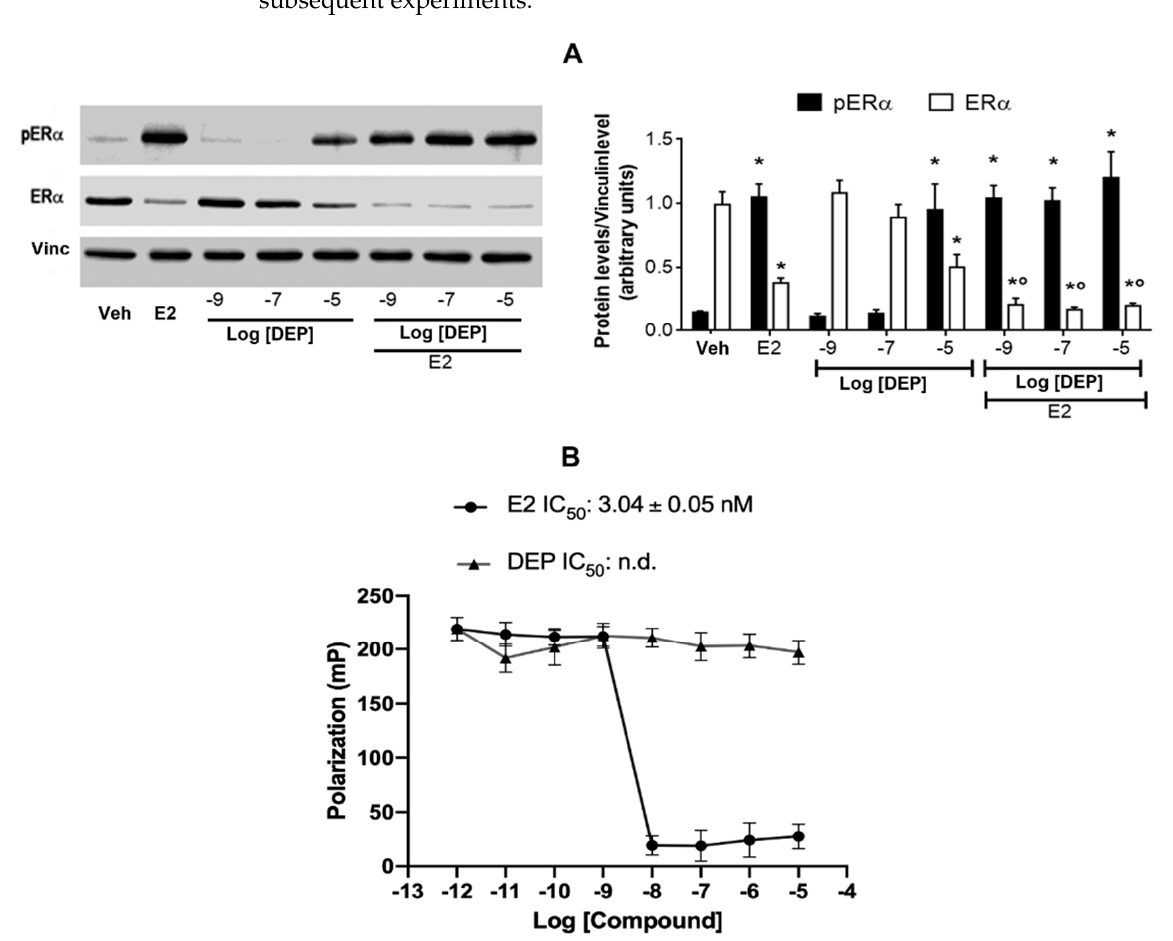
Figure 1. ER α activation and in vitro binding assays. Western blot ( left panel ) and corresponding densitometric analysis ( right panel ) of Ser118-phosphorylated ER α and total ER α protein level in MCF-7 treated for 1 h with the endogenous ER α ligand E2 (10 − 8 M) as positive control, and a dose curve of DEP at 10 − 9 , 10 − 7 , and 10 − 5 M in the presence or absence of E2 co-treatment ( A ). The vinculin levels were used as an internal control of protein loading. Data are means ± SD of at least four experiments. p < 0.01 was determined by the ANOVA test followed by the Bonferroni post-test vs. Veh (*) and E2 ( ◦ ). In vitro ER α competitive binding assay for the endogenous ligand E2 and DEP performed over the 10 − 12 –10 − 5 M range by using fluorescent E2 as a tracer. Inhibitor concentration (IC 50 - nM) is indicated in the panel for each compound ( B